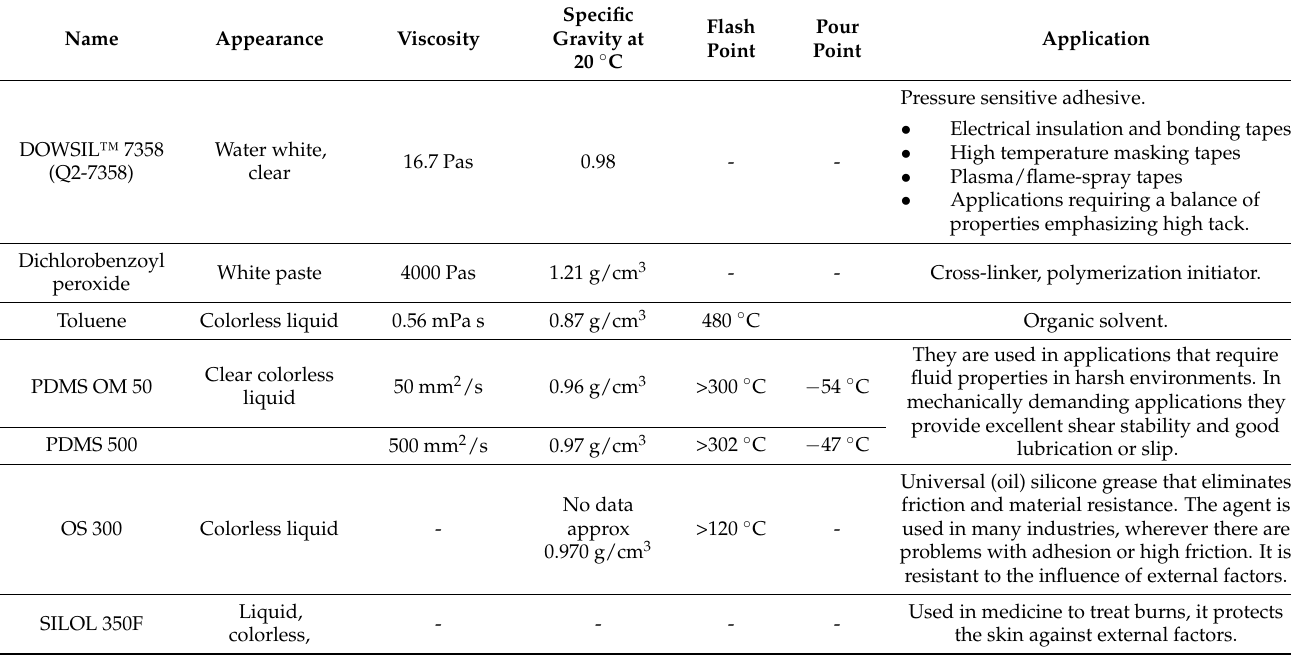
Table 1. Physical and chemical properties of substances used in the